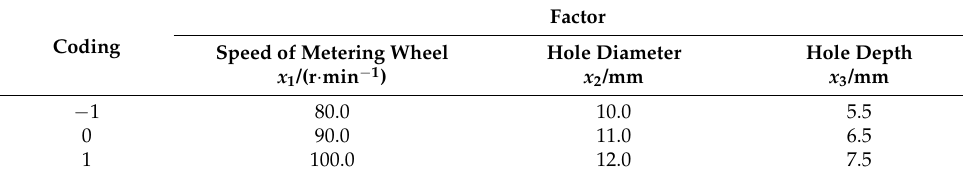
Table 2. Coding with factors and levels.